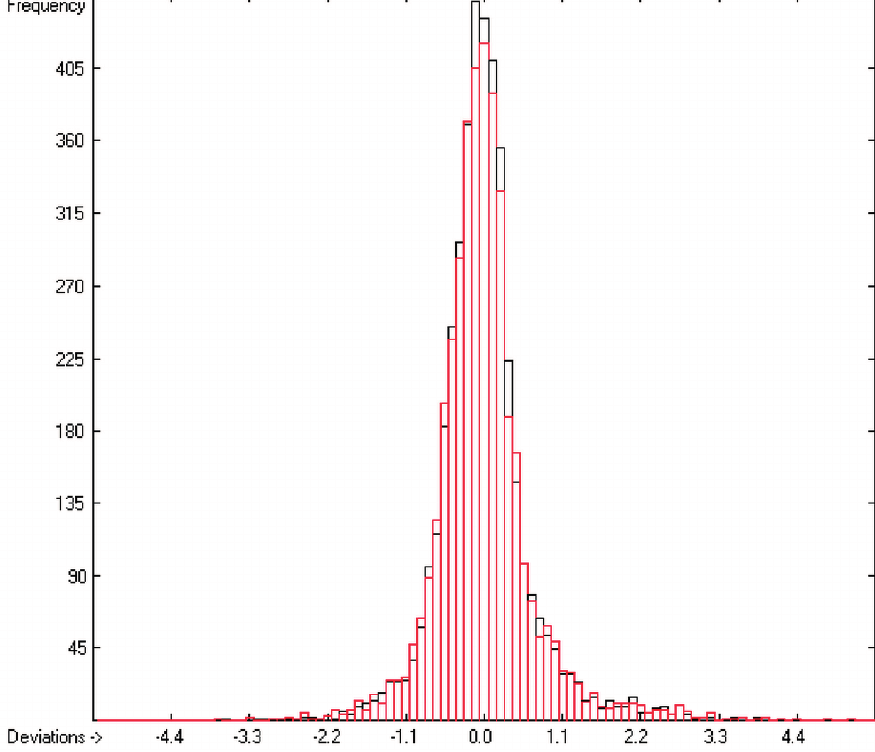
Figure 11. Histogram of refractivity data (S =